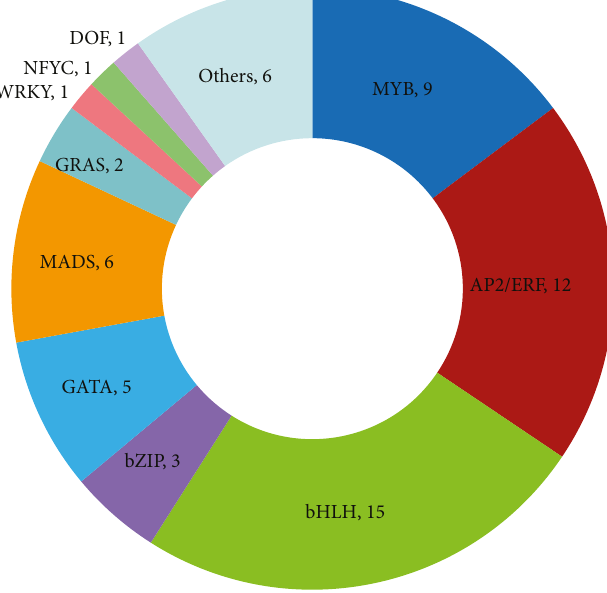
Figure 8: Classi fi cation of signi fi cantly upregulated TFs. Table 5: Di ff erentially expressed genes and their primer sequences in